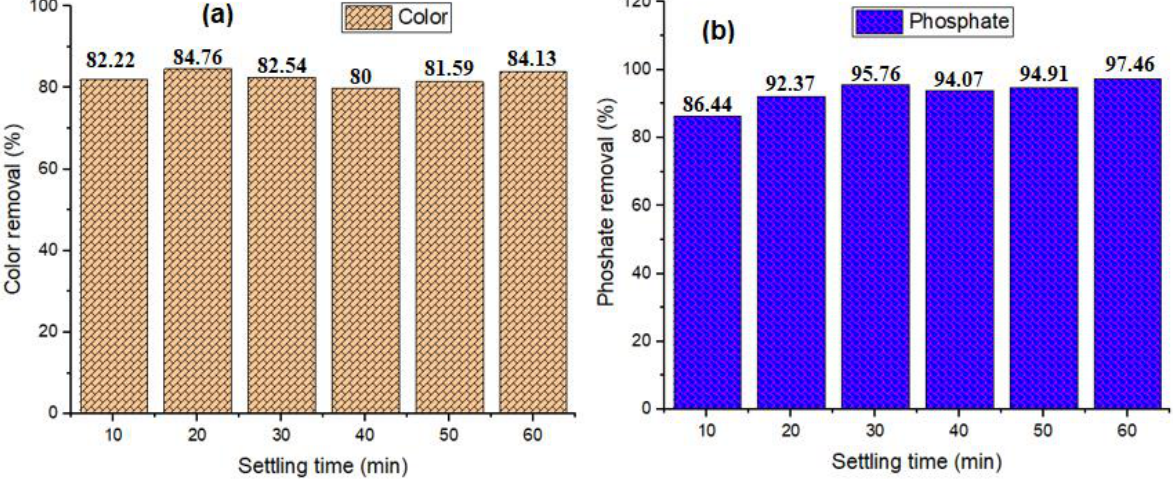
Figure 7. Effect of settling time using RF (1:1) for color removal ( a ) and phosphate removal ( b ).